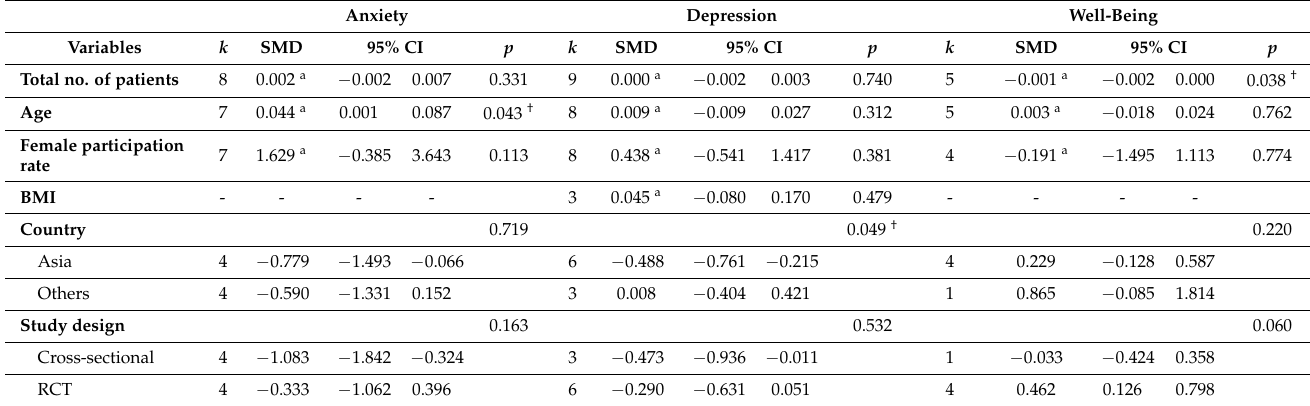
Table 2. Results of the meta-regression analysis of the effects of forest